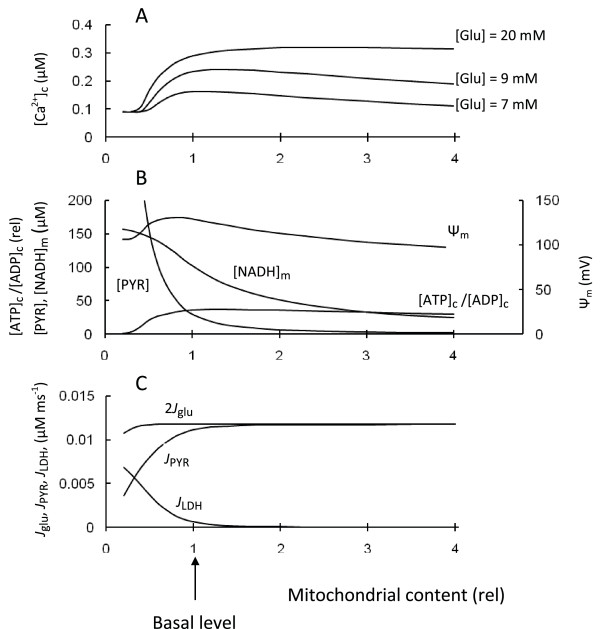
Steady-state simulations of parameters in response to changes of mitochondria content. We simultaneously changed all maximal rates of mitochondrial processes (JPYR, Jhres, Jph, Jhl, jTNADH, Juni, JNCa)- The arrow corresponds to the basal maximal rates and mitochondrial volume from Tables 2 and 3 (shown on axis as 1). A: [Ca2+]c at different glucose levels. B: Ψm, [PYR], [NADH]c and [ATP]c/[ADP]c at medium glucose level (9 mM); C: 2 Jglu, jPYR and JLDH at medium glucose level (9 mM). All other parameters were set as in Tables 2 and 3.